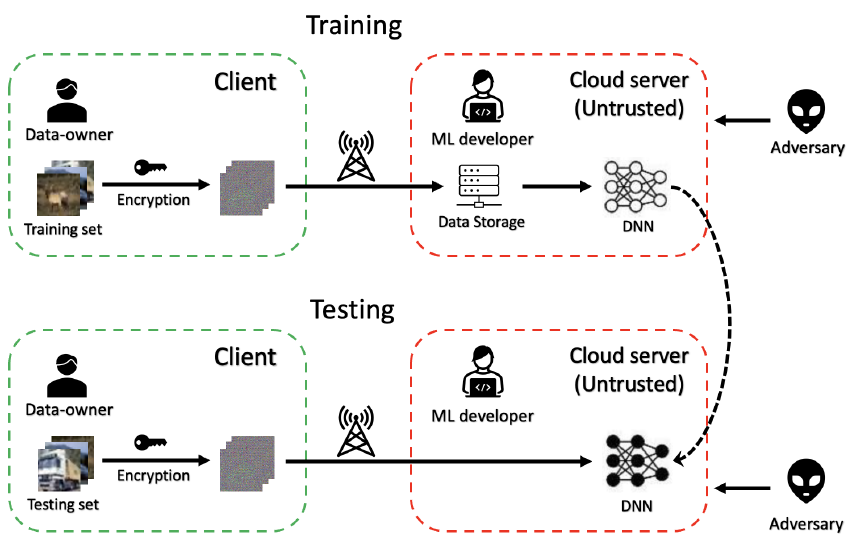
Figure 1. Scenario of proposed